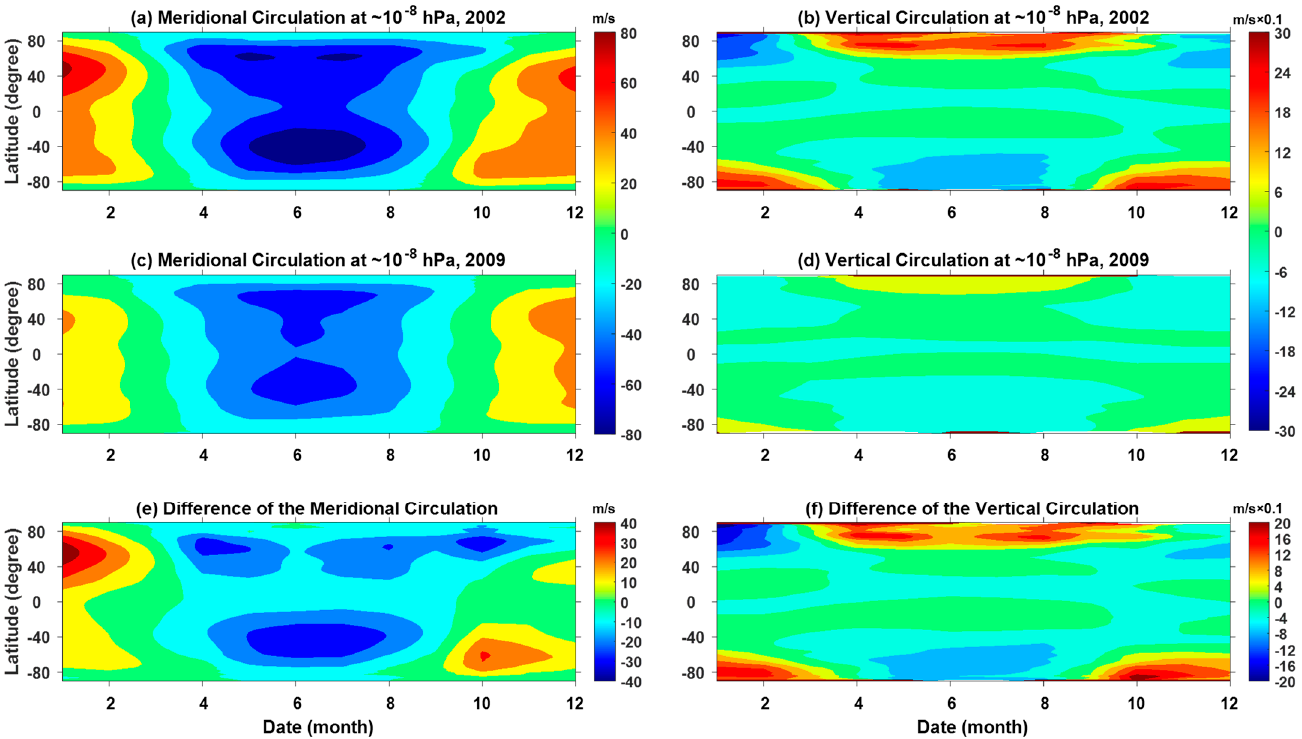
Figure 5. Temporal variations in the ( a , c ) meridional circulation and ( b , d ) vertical circulation at ~70° S in ( a , b ) 2002 and ( c , d ) 2009. ( e , f ) Differences in the meridional and vertical circulation, respectively.